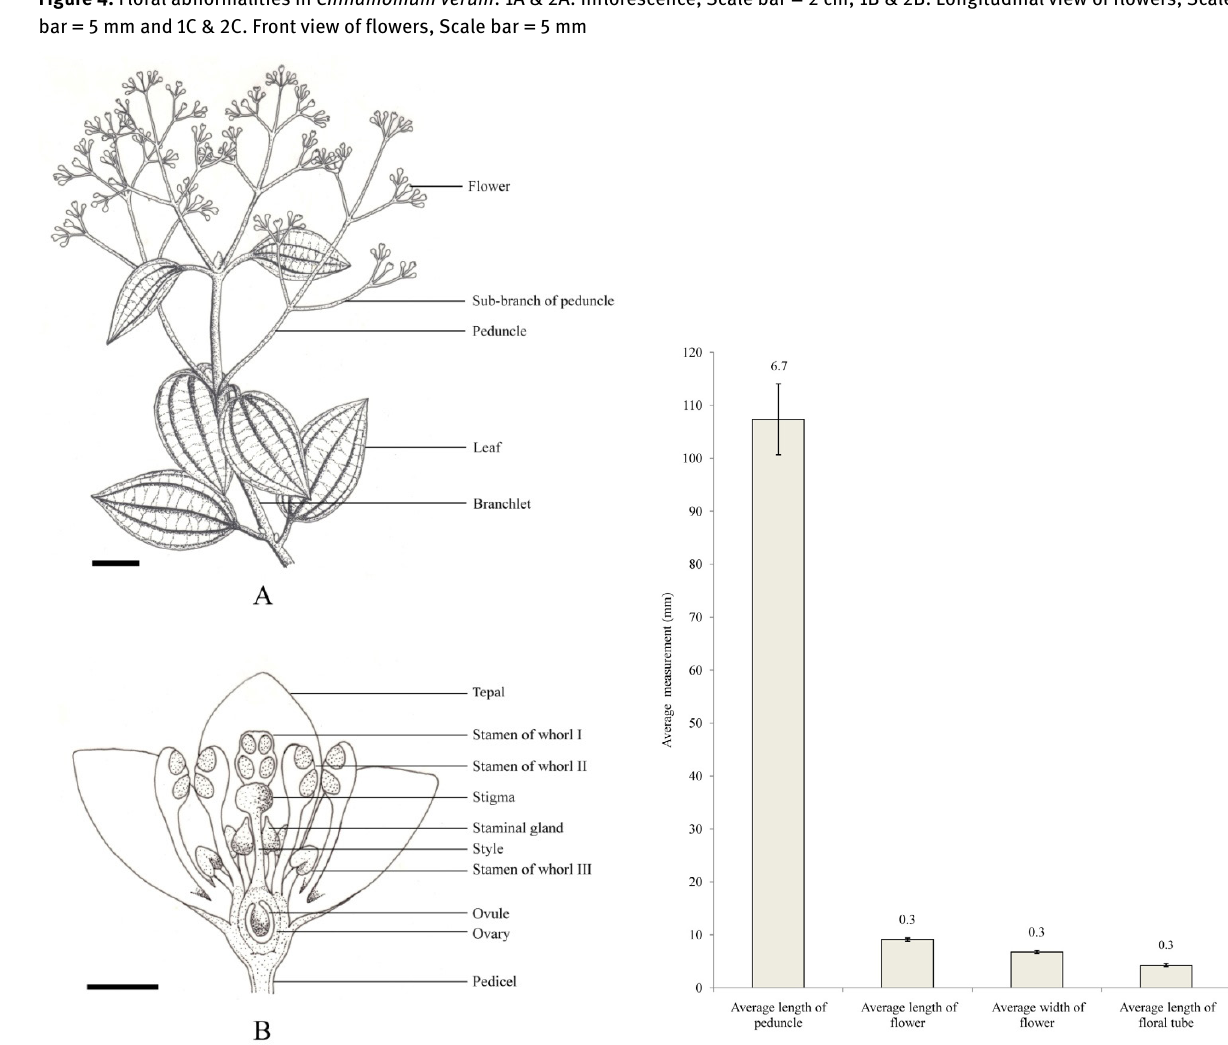
Figure 5: A. Diagram showing typical inflorescence of a single shoot of Cinnamomum verum . Scale bar = 2 cm. B. Longitudinal section of a typical flower. Scale bar = 1 mm